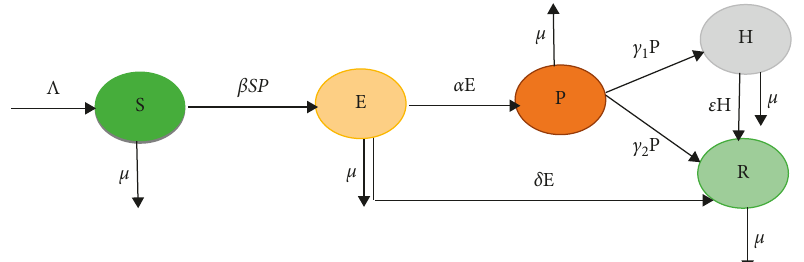
Figure 1: The flow diagram of violence